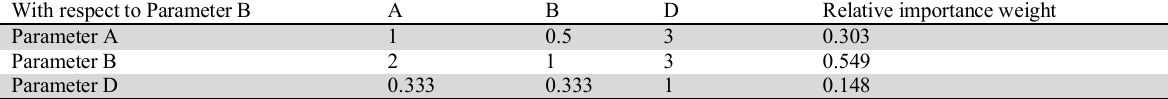
With respect to Parameter